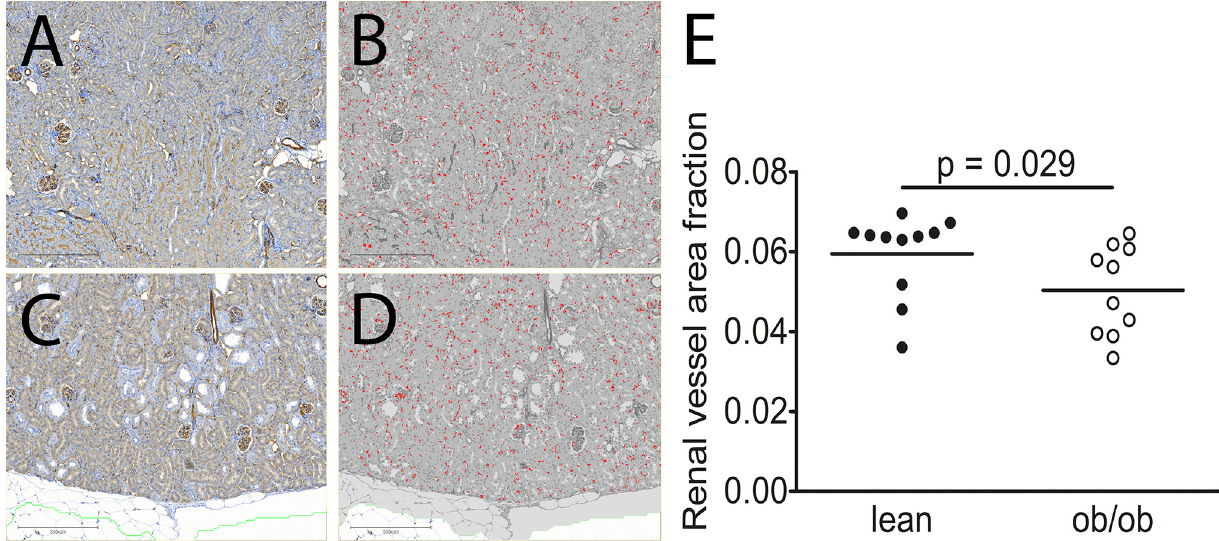
Fig 5. Reduced renal vessel area fraction in ob/ob mice at 21 weeks of age. Renal vessel area fraction was measured in lean (n = 11) and leptin-deficient (ob/ob, n = 10) mice at 21 weeks of age. A-D: Representative samples of kidney sections immunostained with Lectin I. A: Lectin I in lean mice. B: Computerized image analysis in lean mice. C: Lectin I in ob/ob mice. D: Computerized image analysis in ob/ob mice. E: Renal vessel area fraction was calculated as the mean area fraction of the identified small vessels compared to the total kidney tissue area examined. Values are presented as individual datapoints and means. Statistical analysis was performed using Mann-Whitney U-test and a p-value of less than 0.05 was considered